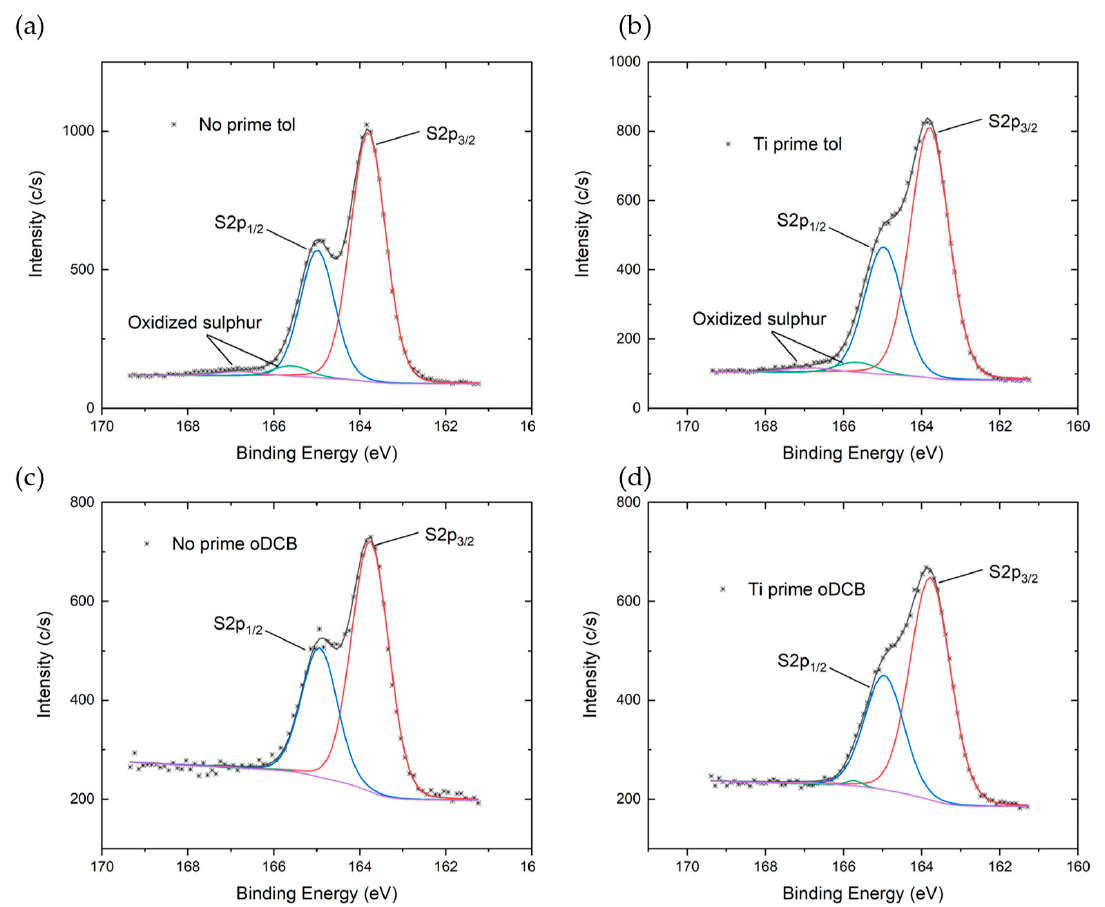
Figure 3. High resolution S2p spectra of P3HT deposited on Si / SiO 2 substrate ( a ) from toluene solution without adhesion promoter, ( b ) from toluene solution with Ti prime, ( c ) from oDCB solution without adhesion promoter, and ( d ) from oDCB solution with Ti prime.